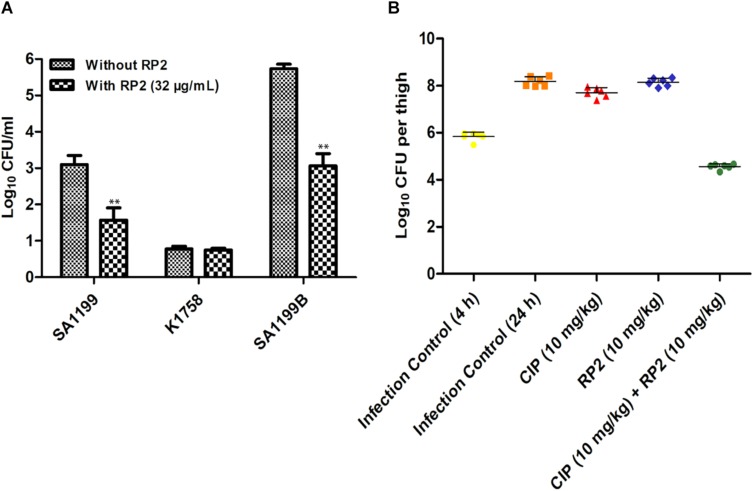
(A) Influence of RP2 (32 μg/mL) on the invasive abilities of S. aureus wild-type SA-1199, NorA over-producing S. aureus SA-1199B and the norA knock-out K1758. The results presented correspond to the mean of three independent readings ± SD. Results were considered significant when ∗P < 0.05 and highly significant when ∗∗P < 0.01 and ∗∗∗P < 0.001. (B) Neutropenic murine thigh infection model. Single dose (subcutaneous; 4 h after infection, 6 mice per group) treatment with ciprofloxacin and RP2 alone and in combination against S. aureus SA-1199B; for drug-treated animals, thigh CFU was determined at 20 h after infection. For controls, CFU in thighs was estimated at 4 and 20 h after infection. The CFU from each thigh are plotted as individual points and error bars represent the SD within an experimental group.